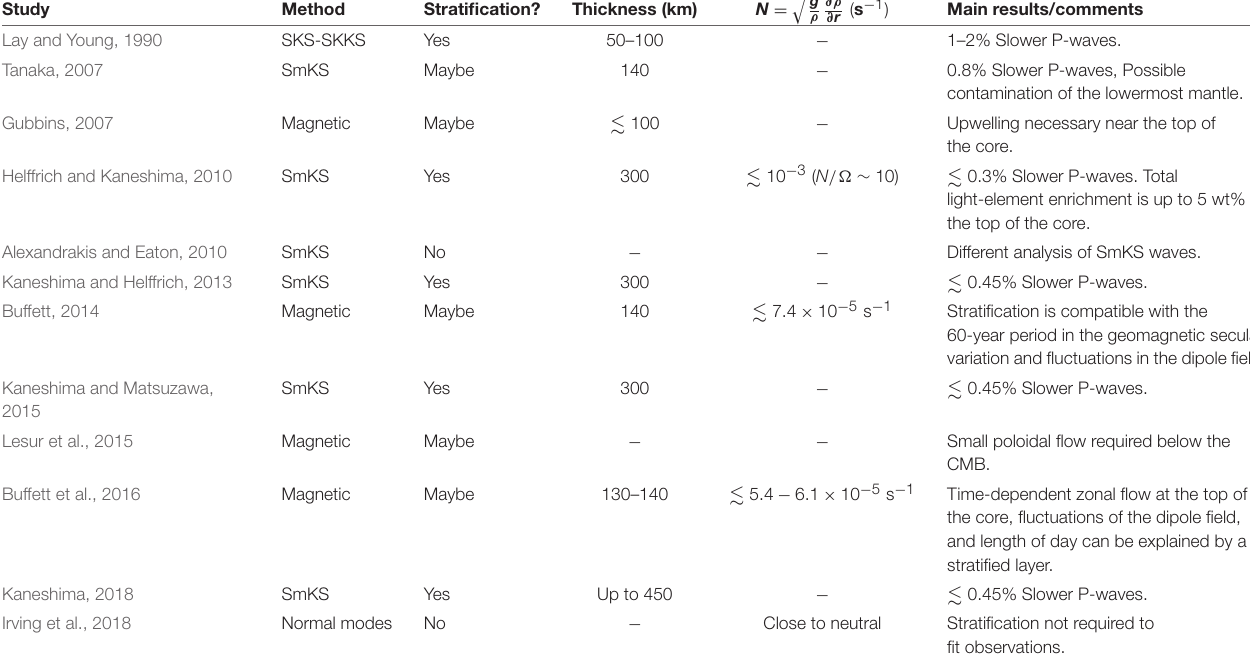
TABLE 2 | List of the main studies that proposed some constraints on the stratified layer at the top of the Earth’s core based on either magnetic or seismic observations.